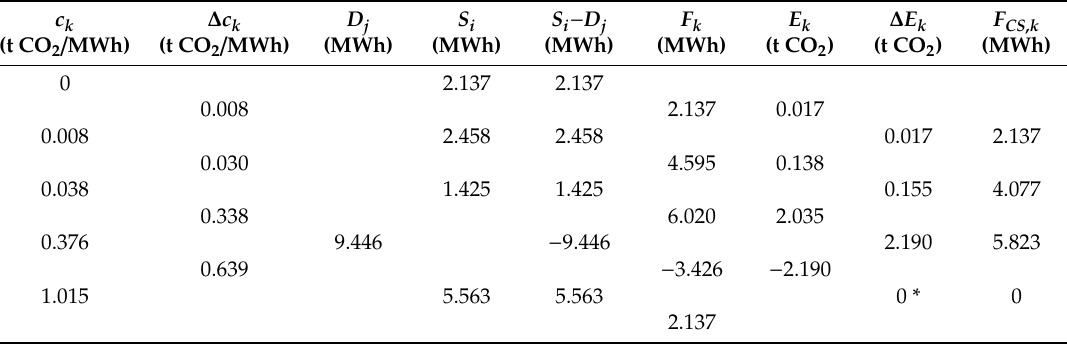
Table 4. Minimum zero-carbon energy solution applying cascade